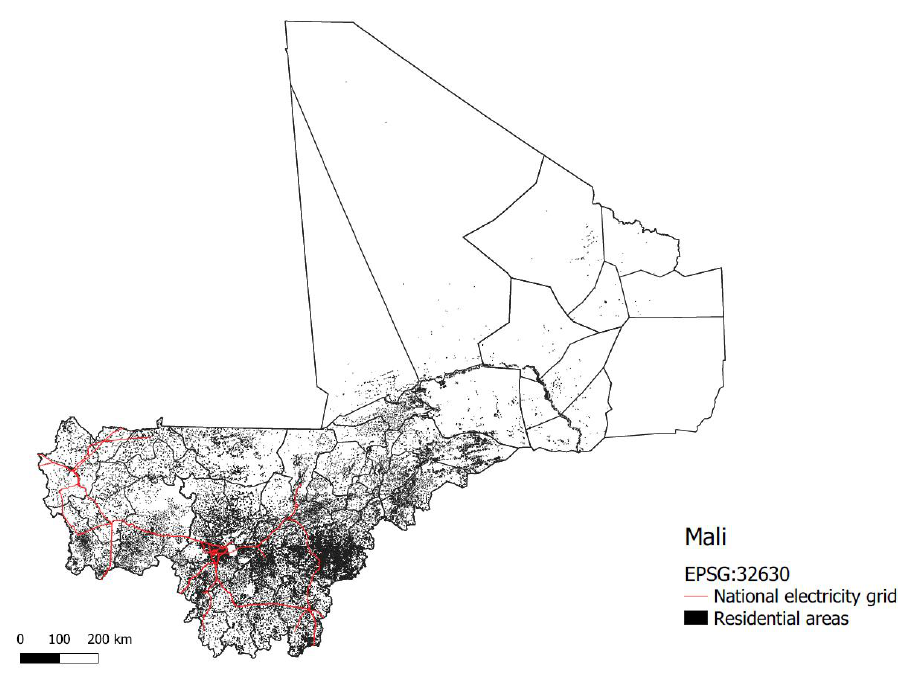
Figure 1. Population distribution and electricity grid of Mali. Using data from [42,43].